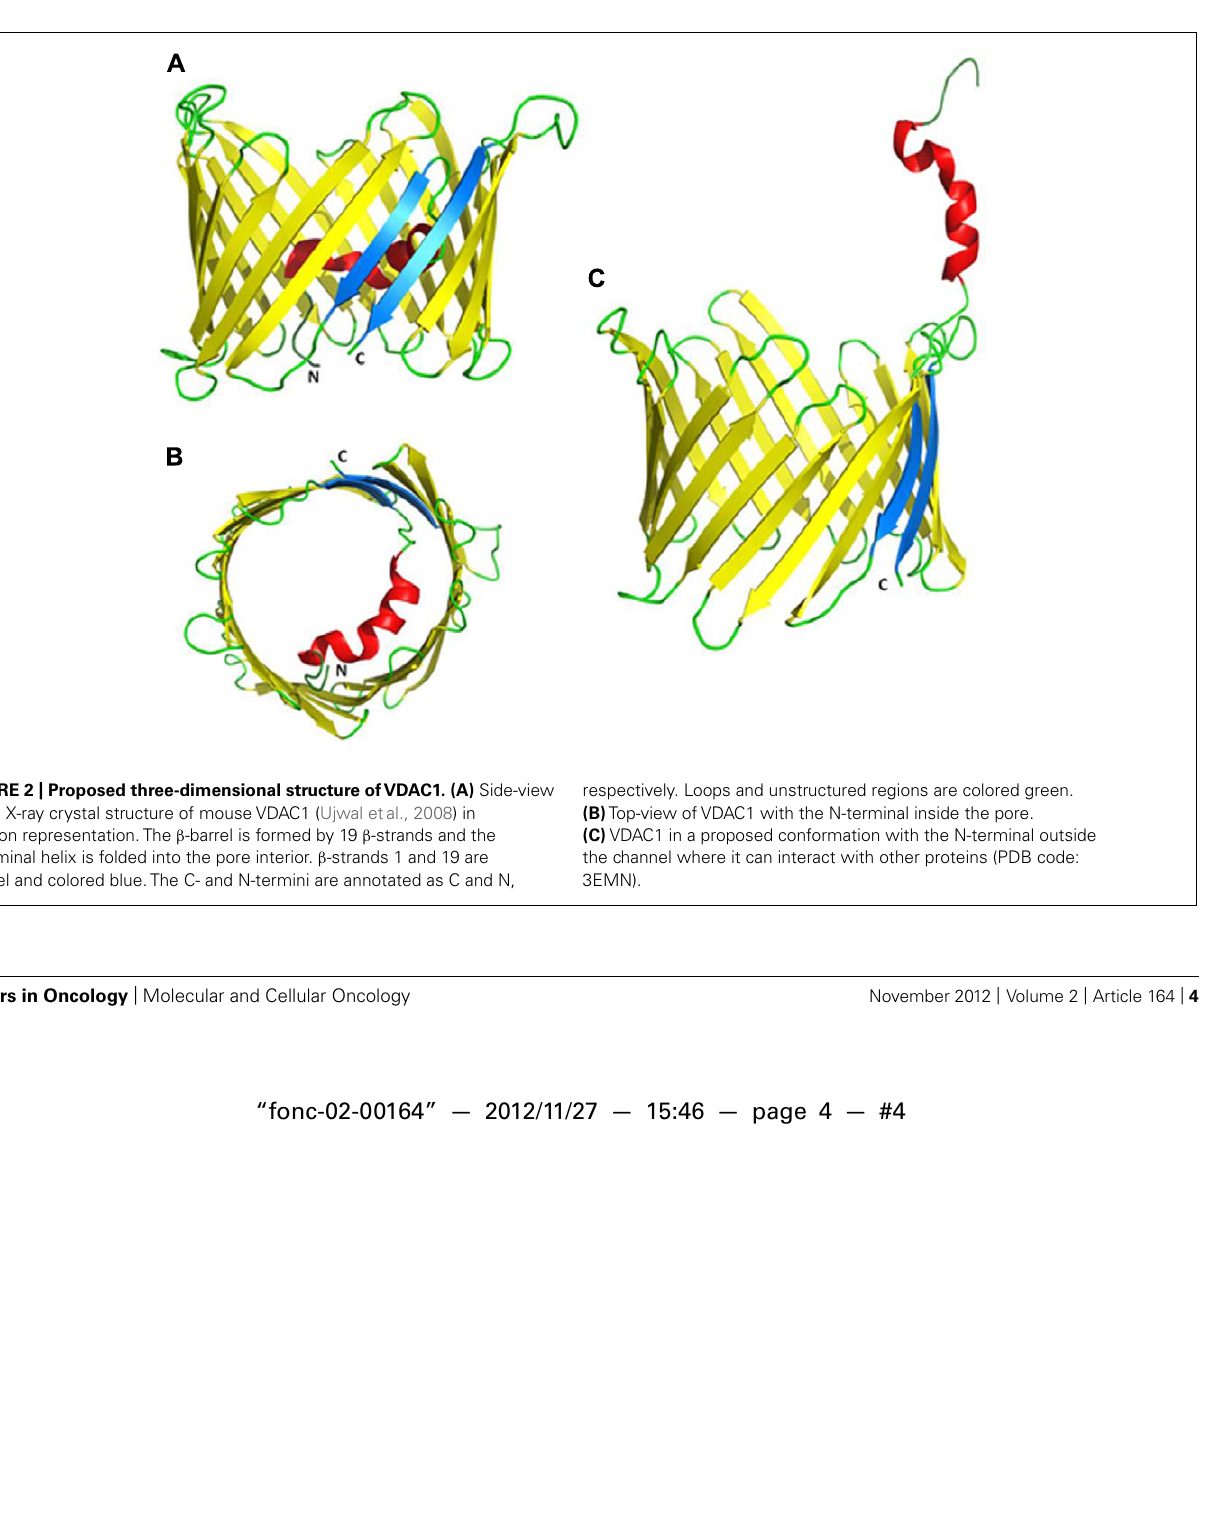
respectively. Loops and unstructured regions are colored green. (B) Top-view ofVDAC1 with the N-terminal inside the pore. (C) VDAC1 in a proposed conformation with the N-terminal outside the channel where it can interact with other proteins (PDB code: